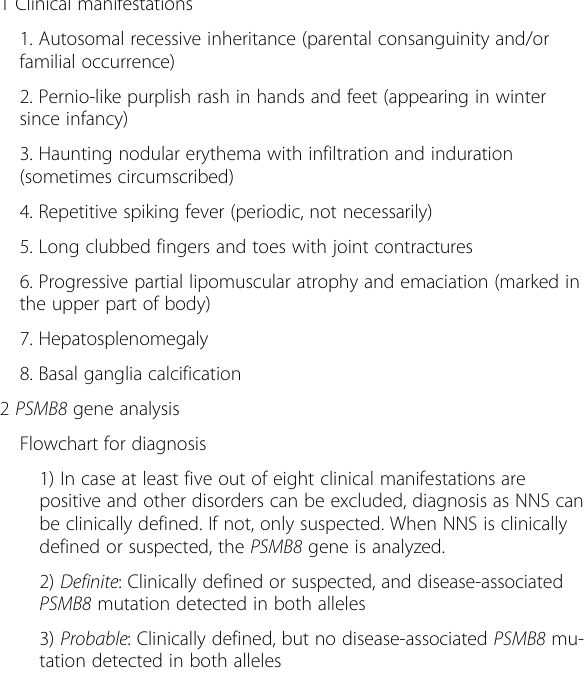
Table 1 Diagnostic criteria for Nakajo-Nishimura